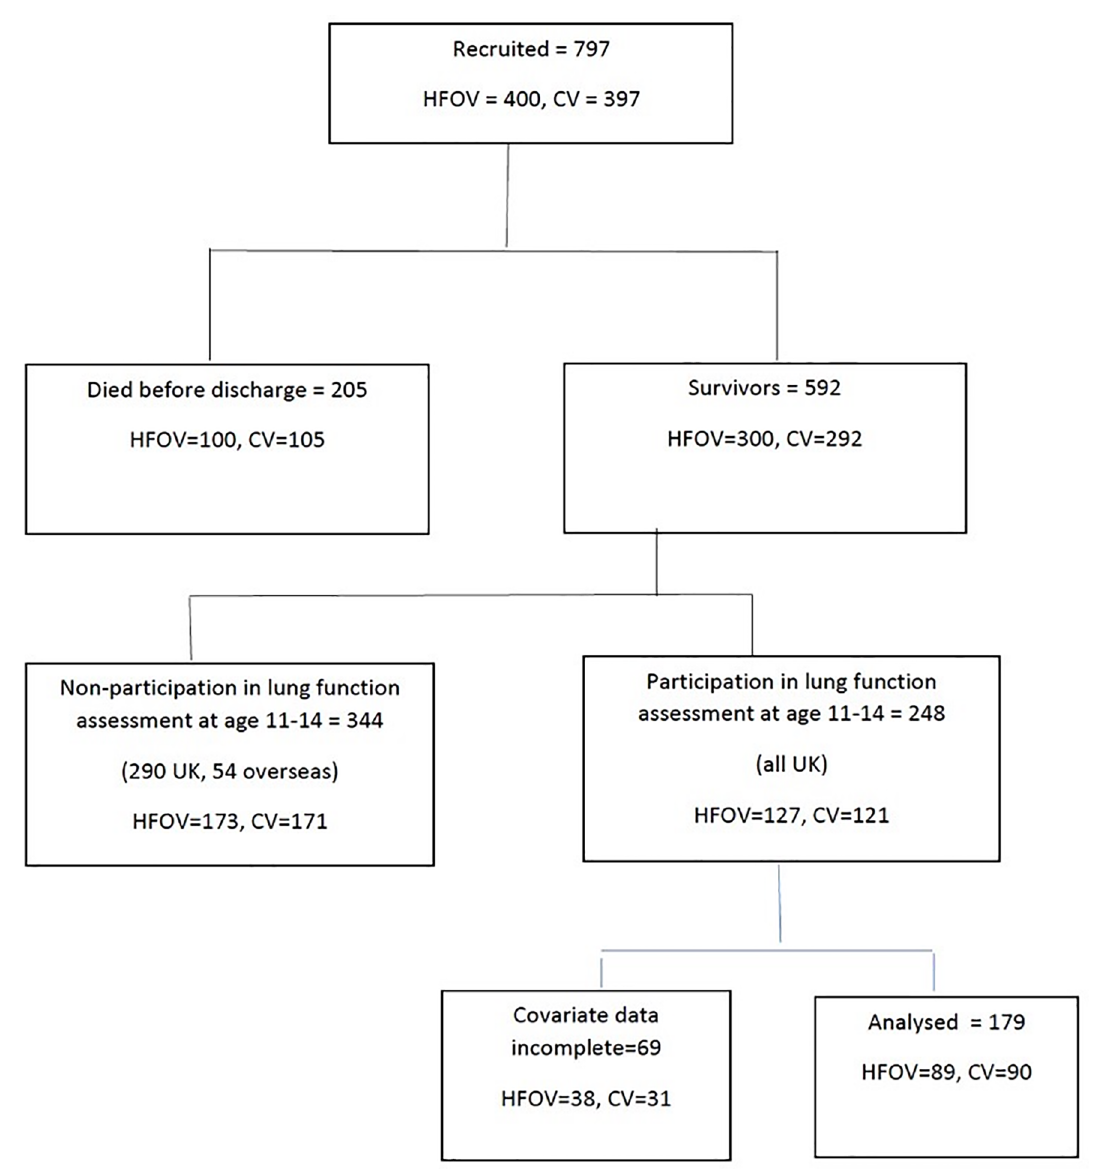
Fig 1. Study flow chart.